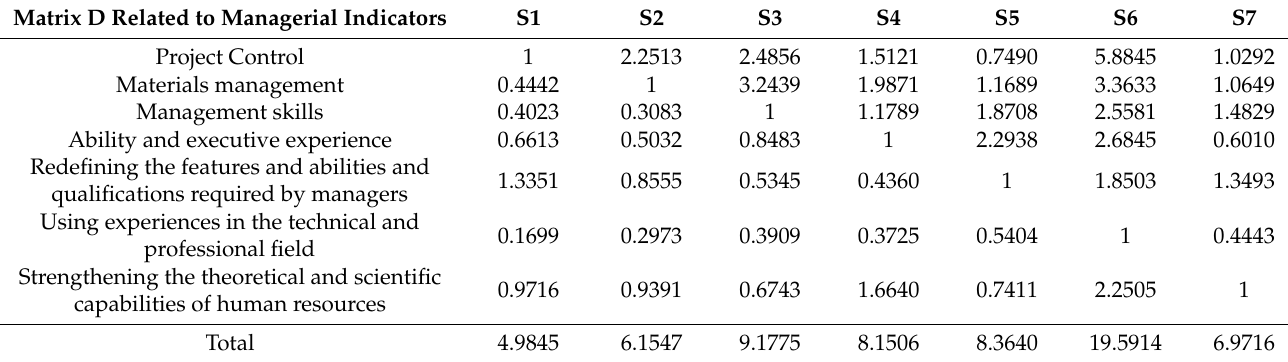
Table 5. Pairwise comparison matrix related to management indicators.